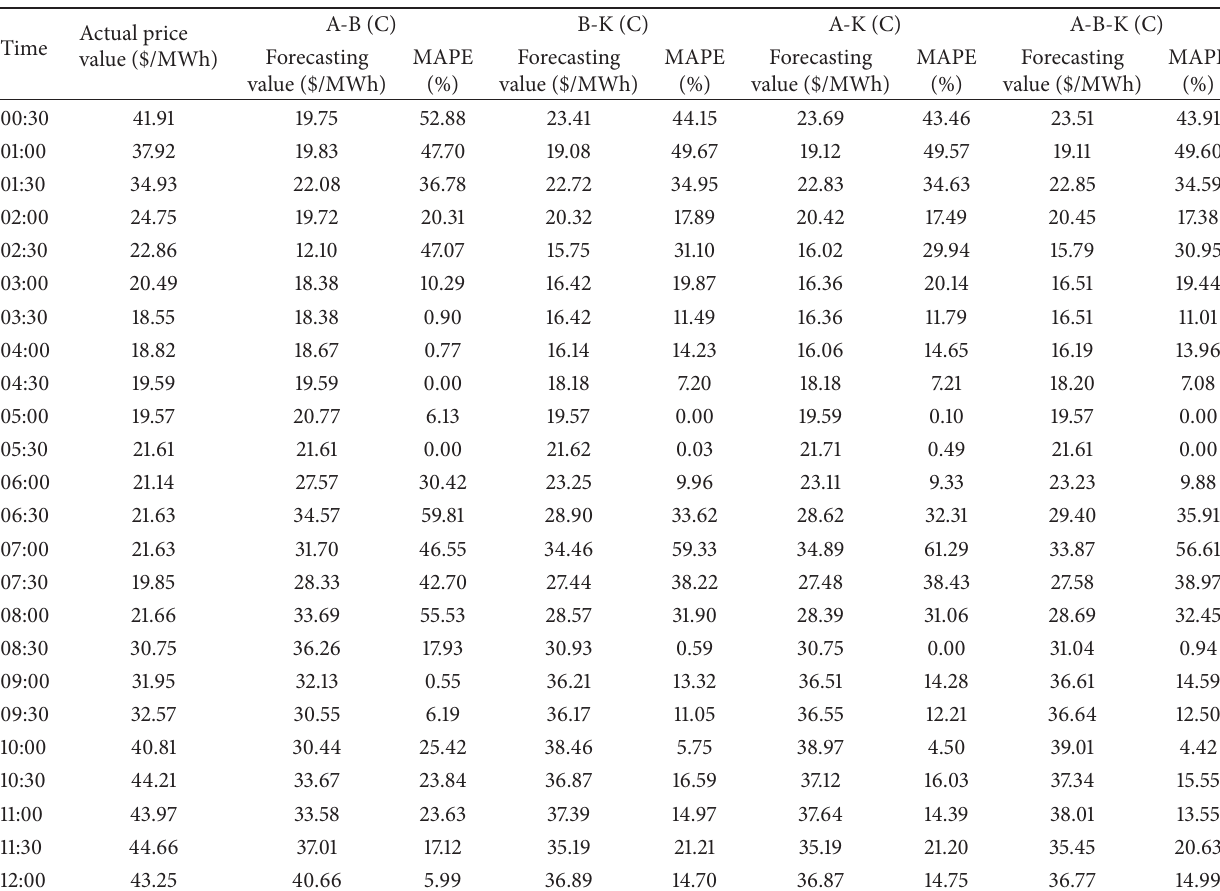
Table 4: CPSO weight-determined combination models forecasting